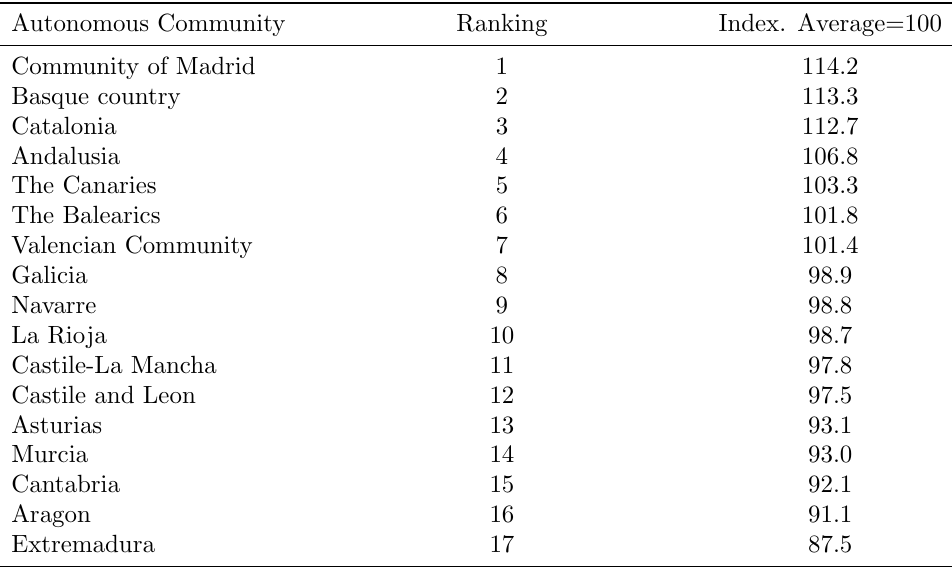
Table 1: MoniTUR 2010 global